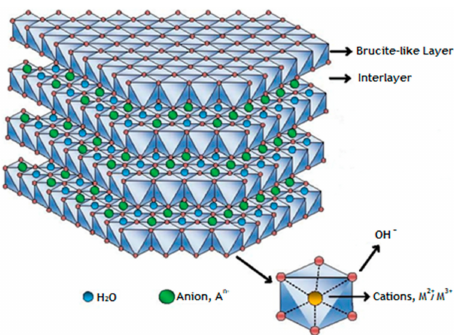
Figure 12. Schematic representation of the hydrotalcite structure. Adapted from Tronto et al.